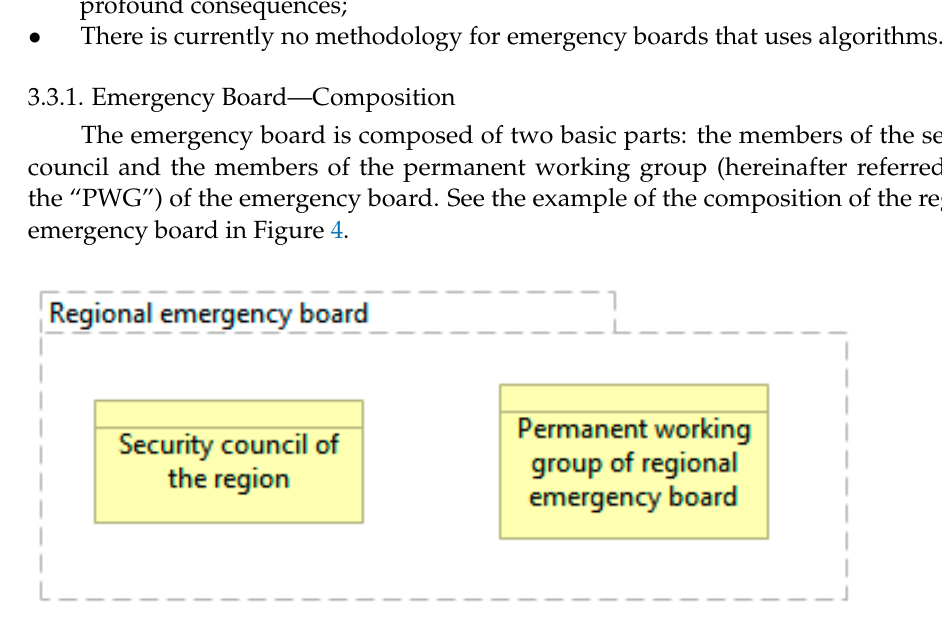
Figure 4. Emergency board of the region—general composition.